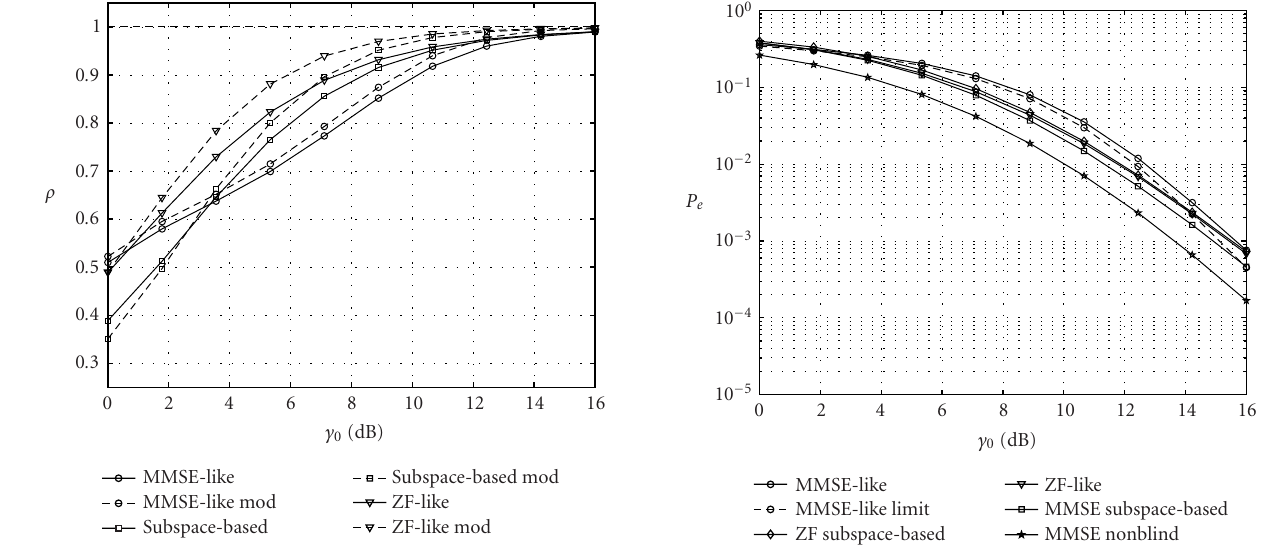
Figure 9: Probability of error for the blind receivers; noncoopera- tive reception with hard integration: K = 4, M = 8, n t = 2, n r = 2, Q = 1300, and P = 1500.